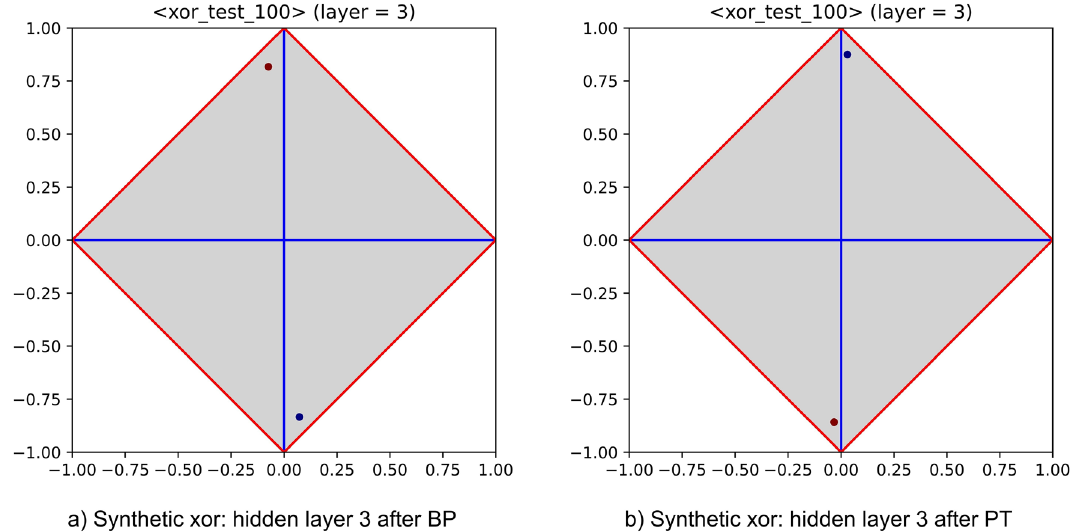
Figure 7. Success patterns of an MLP equipped with three hidden layers (embedding 10, 4 and 2 neurons) trained with BP and PT (left- and right-hand side), on the synthetic xor dataset. Note that the rise of a success pattern is clearer for